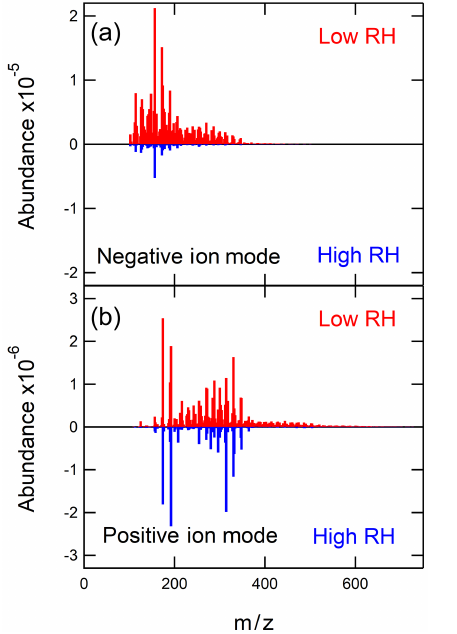
Figure 1. High-resolution mass spectra obtained in negative ion mode (a) and positive ion mode (b) . The red upward-pointing mass spectra represent the low-NO x SOA sample made under low RH ( < 2%) and the blue inverted mass spectra represent the low-NO x SOA sample made under high RH (75%).